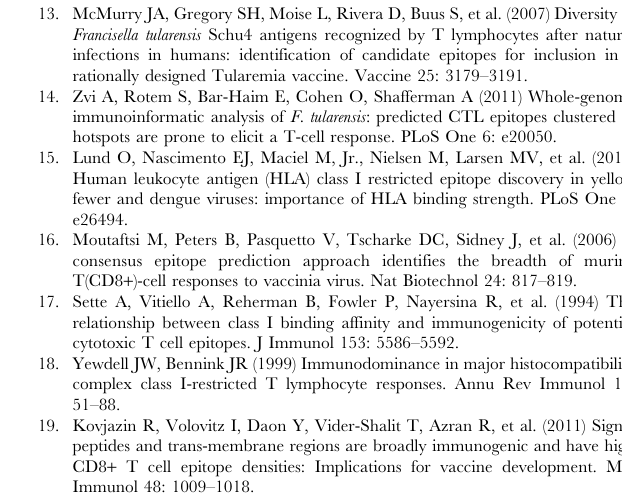
Table S2 List of 200 peptides contained in the 41 parental proteins of responder peptides, and selected from regions outside high density clusters (1.0–1.4) in these 41 proteins. The affinity provided is the IC 50 value predicted for a particular responder sequence by the NetMHC3.0 program, and the threshold for binding affinity is 500 nM. The gi number and annotation of the source protein are according to the F. tularensis holarctica LVS sequence deposited at the NCBI (GenBank accession AM233362); (a) Responders are indicated by their magnitude of T-cell response as follows number of spots/million cells) is: L (Low): 5–20; M